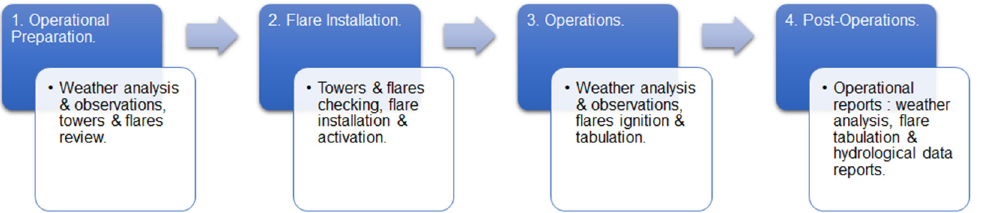
Figure 6. The daily standard operating procedure (SOP) applied for each operating tower in the 2020 GBG operations in the Larona Basin, Sorowako, Sulawesi.